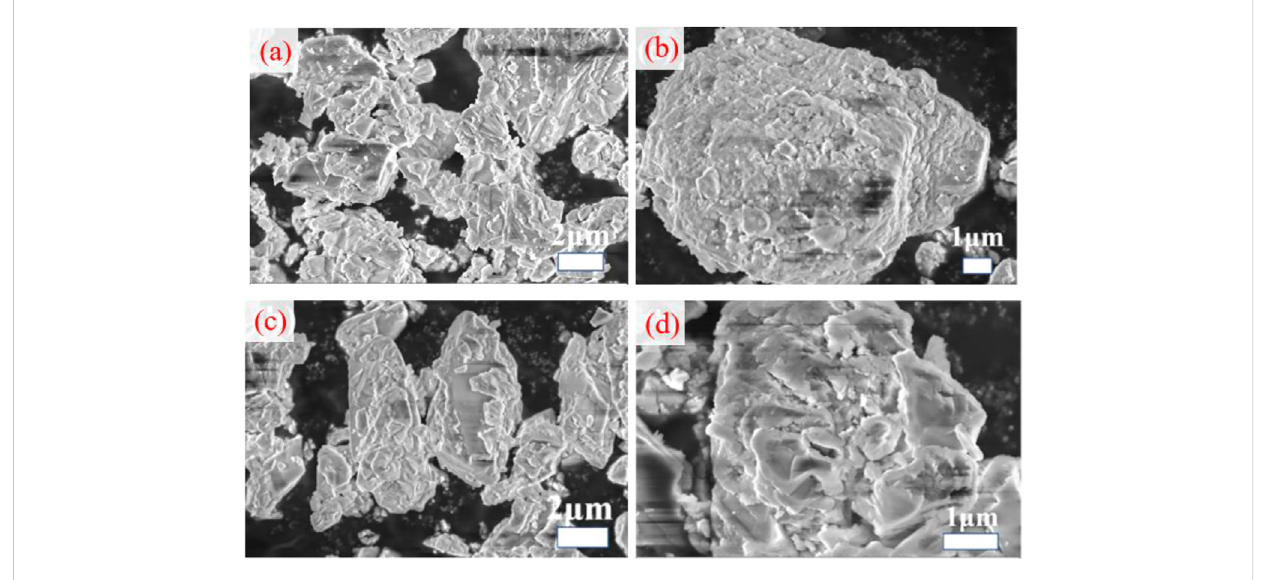
FIGURE 7 SEM picture, (A) Unmodi fi ed GCC, (B) TCA-201 modi fi ed GCC, (C) TCA-K38S modi fi ed GCC, (D) sodium stearate modi fi ed